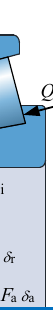
Figure 10. Tapered roller forces and bearing forces.